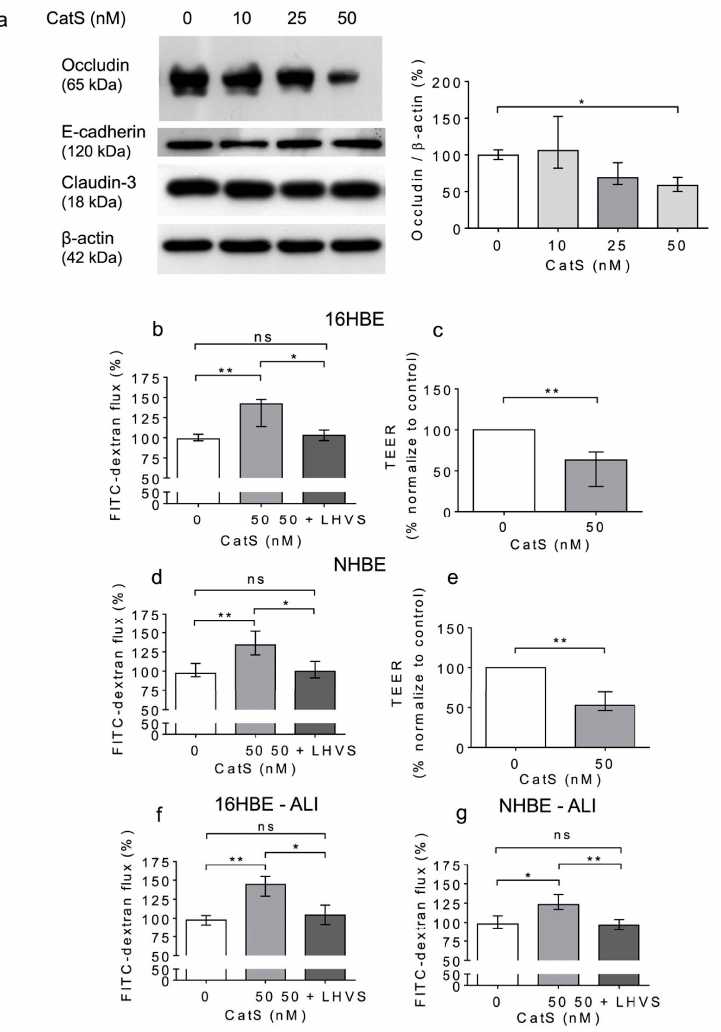
Figure 5. Increased permeability of lung epithelial cells is associated with the CatS-dependent proteolytic damage of occludin. ( a ): 16HBE cells were treated with CatS for 12 h and then lysed. Lysates were submitted to electrophoresis before protein levels of occludin, E-cadherin, and claudin-3 were analyzed by Western blot ( β -actin, load control). A representative sample of three independent Western blot experiments is shown. Densitometric analysis of immunoreactive occludin is also shown. ( b ): 16HBE cells were grown on Transwell inserts (submerged culture) and treated with CatS